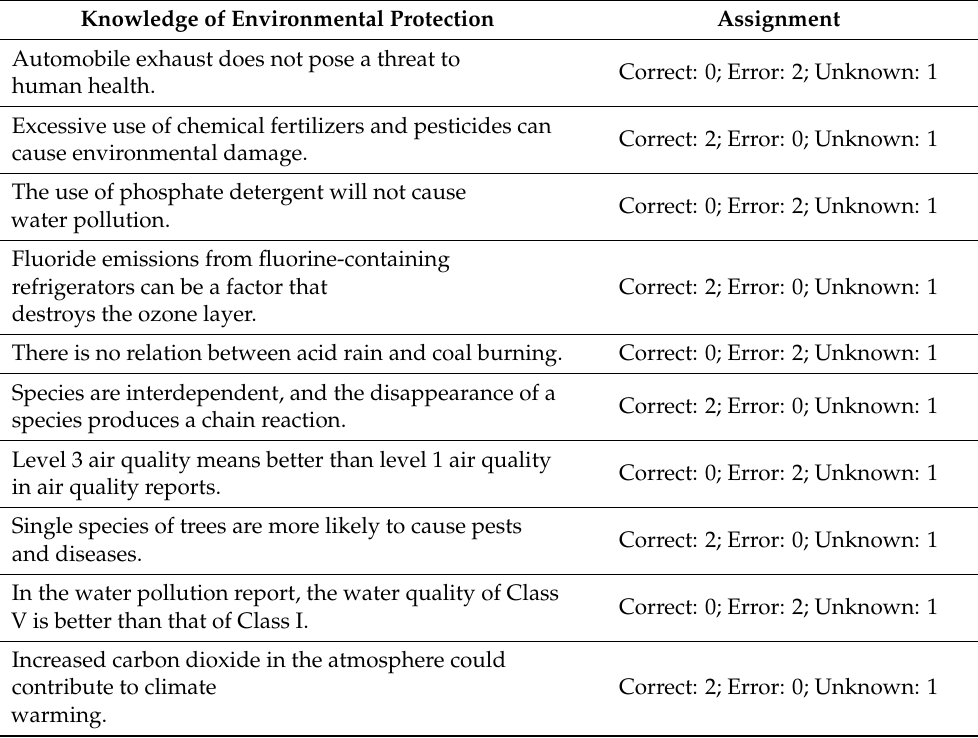
Table 7. Environmental knowledge scale. Knowledge of Environmental Protection